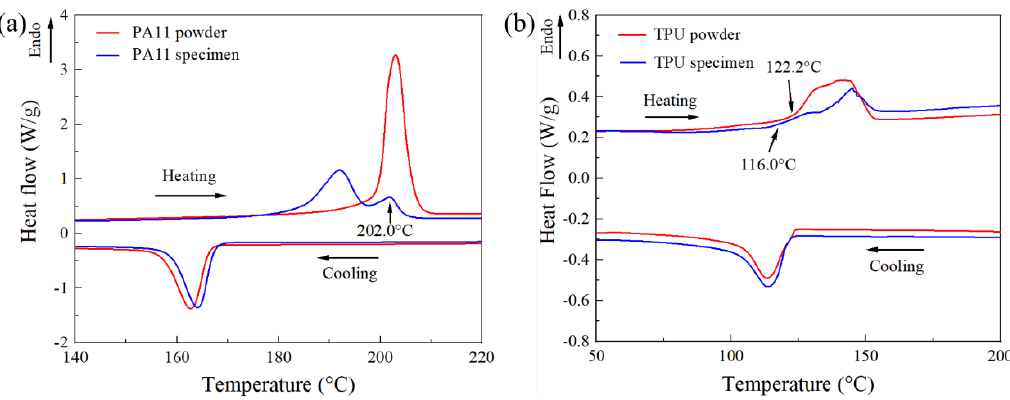
Figure 3. DSC curves of powders and specimens: ( a ) PA11 and ( b ) TPU. The DSC curve of the PA11 specimen showed two endothermic peaks, a main en- dothermic peak at 192.0 ◦ C, and a smaller shoulder endothermic peak at 201.8 ◦ C.